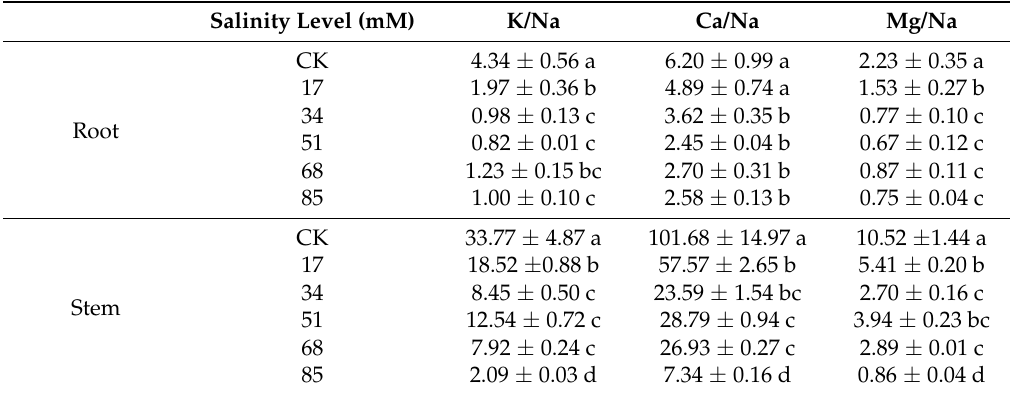
Table 4. Effects of various salinities on the K/Na, Ca/Na, and Mg/Na ratios in the root, stem, leaf, and whole plant of C. turczaninowii seedlings after 42